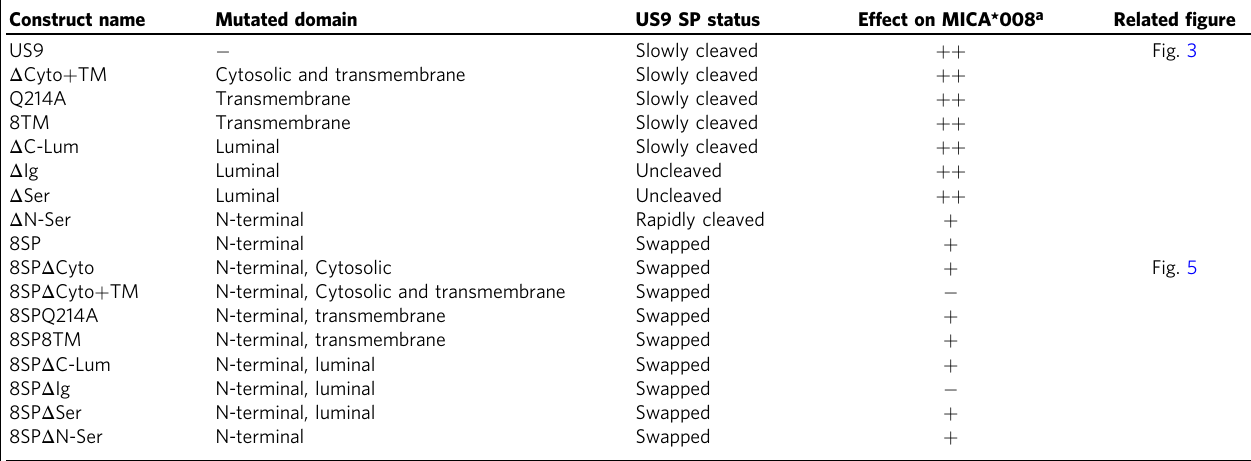
Table 1 Characteristics and function of US9